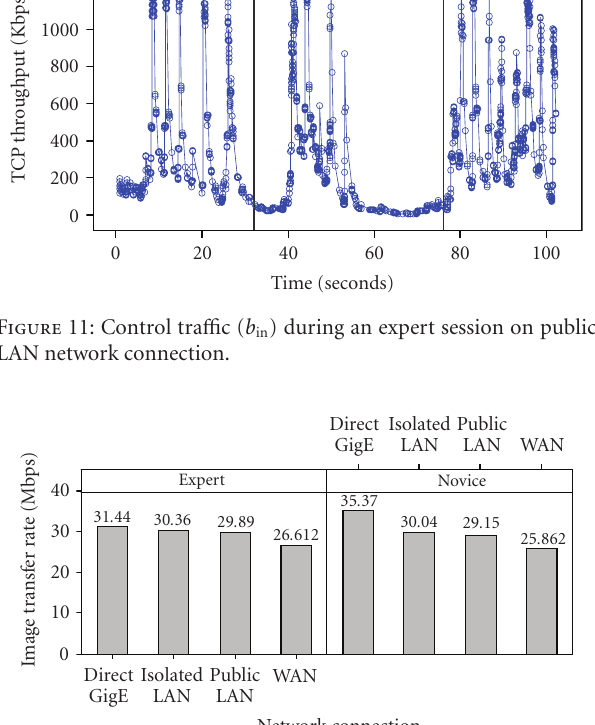
) comparison for varying ψ net out